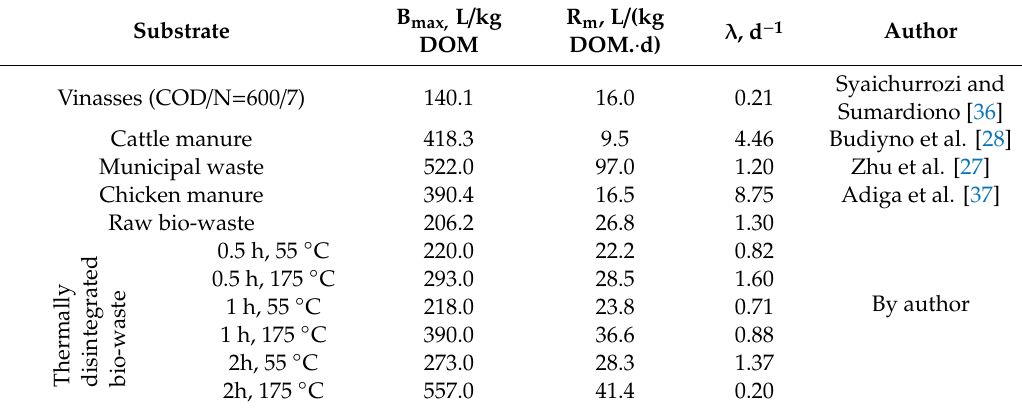
Table 6. Comparison of the results of estimated parameters for bio-waste with the data of other authors (as cited by Syaichurrozi and Sumardiono